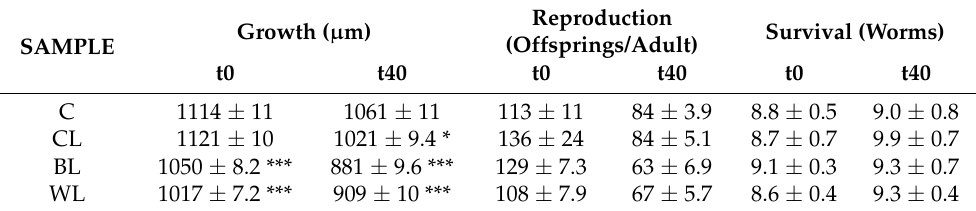
Figure 2. Seed germination percentage and root length of L. sativa in the control (C) and lubricant- spiked soil samples (CL, BL and WL): ( a , b ) data at t0; ( c , d ) data at t40 (n = 3, mean data ± s.e.m.). Significant differences at p < 0.01 (**) and p < 0.001 (***) are shown. Table 1. Growth, reproduction and survival ecotoxicological endpoints of C. elegans in the lubricant- spiked and control soils, at 0 and 40 days post-incubation. Values are given as mean ± s.e.m. (n = 12).